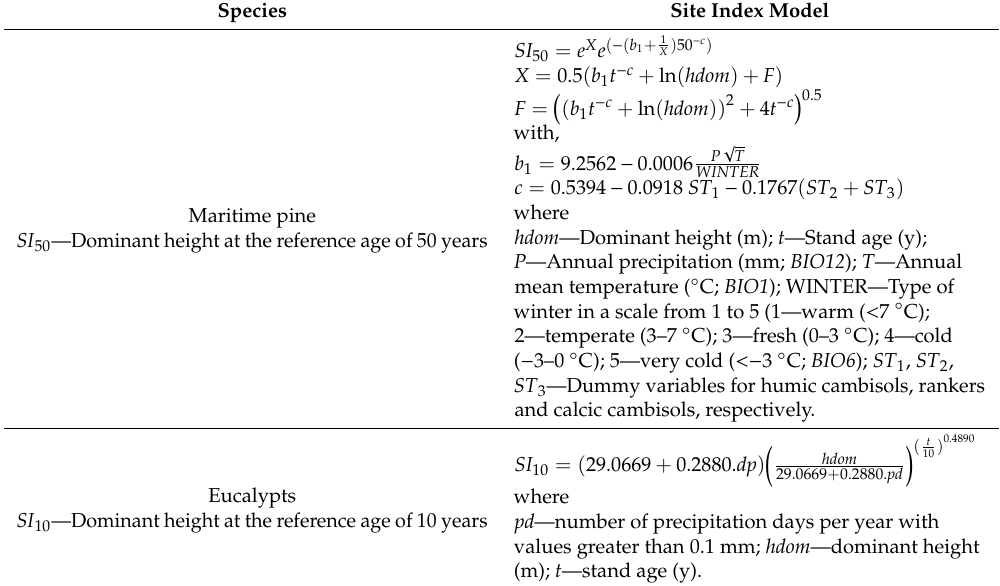
Table 4. Site index models for the species maritime pine [45] and eucalypts [46,47]. Species Site Index Model